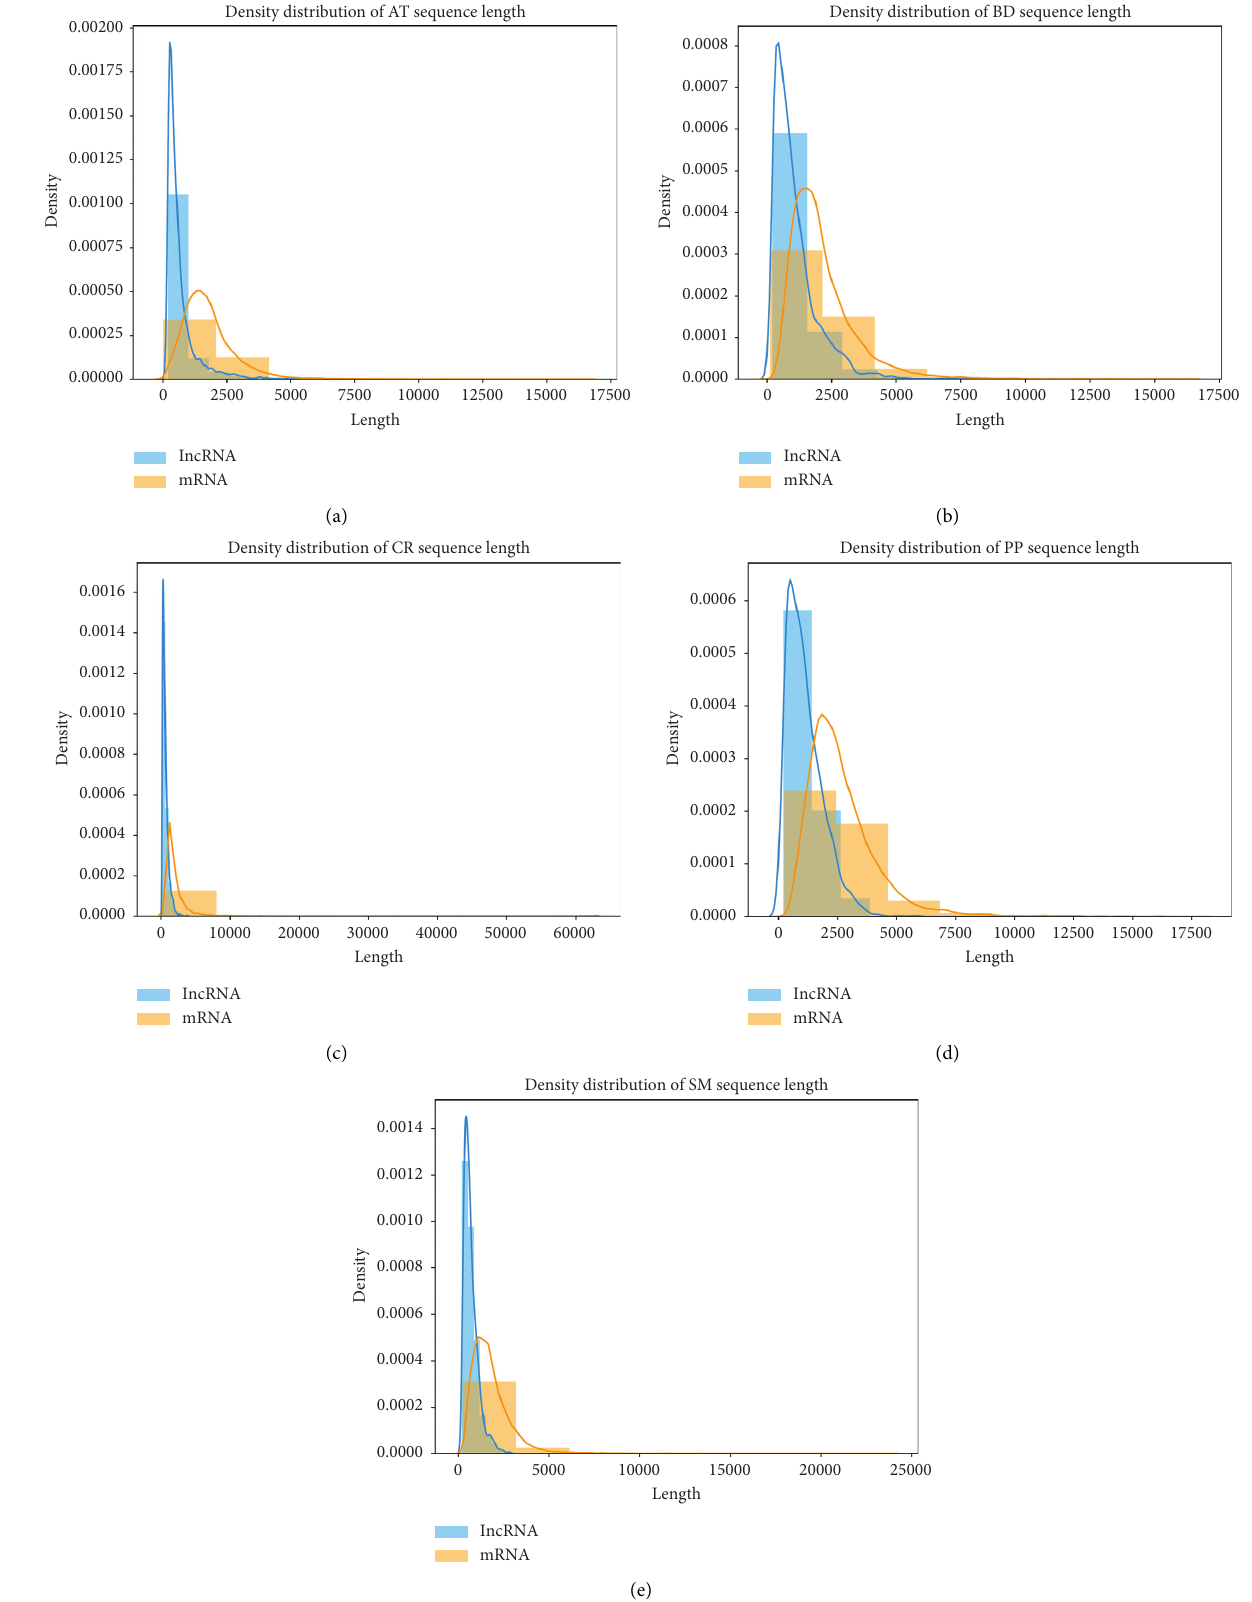
Figure 1: Sequence length frequency distribution of different plants. (a) Arabidopsis thaliana (AT). (b) Brachypodium distachyon (BD). (c) Chlamydomonas reinhardtii (CR). (d) Physcomitrella patens (PP). (e) Selaginella moellendorffii (SM). The horizontal axis is sequence length, and the longitudinal axis represents